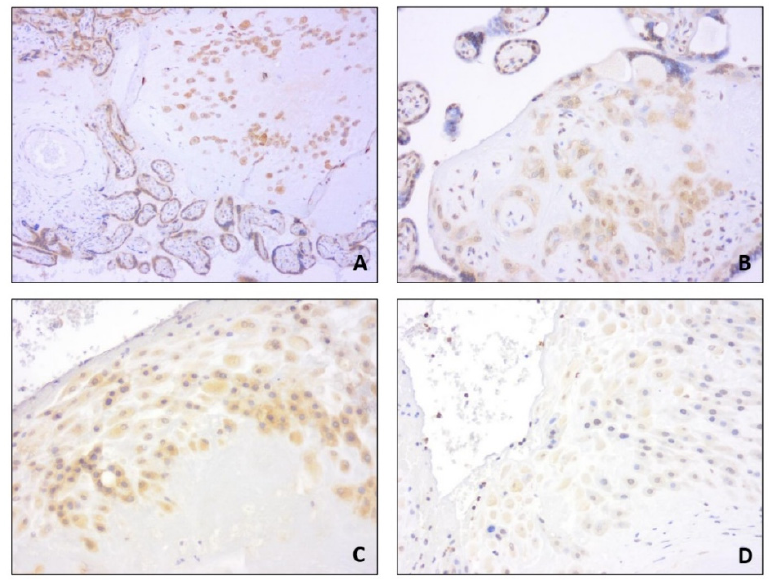
Figure 1. PTH-R1 ( A ) and parathyroid hormone-related protein (PTH-rP) ( B ) expression in extravil- lous cytotrophoblast; PTH-R1 ( C ) and PTH-rP ( D ) expression in decidua.